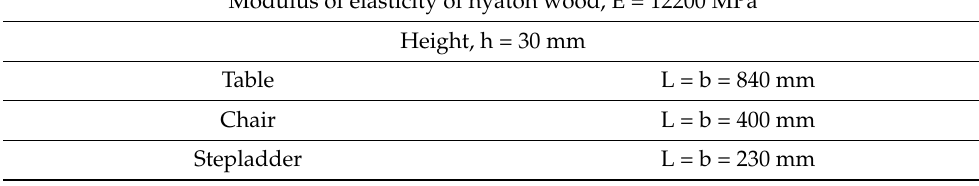
Table 9. Parameter values.